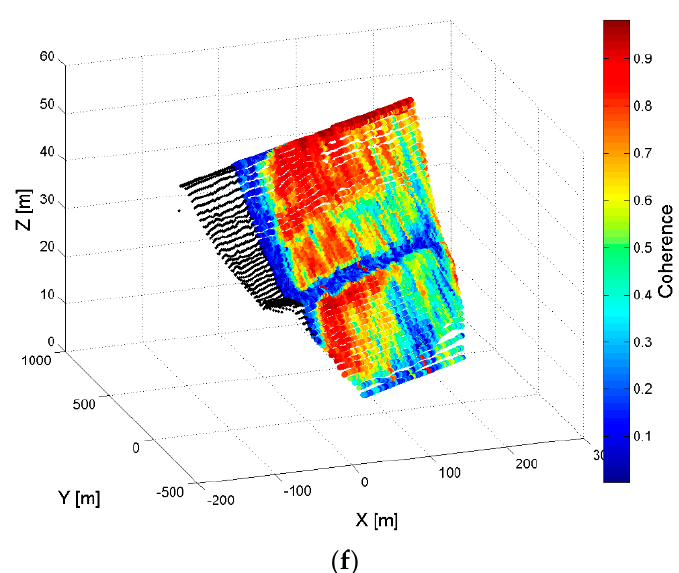
Figure 8. Marana-Capacciotti dam, Cerignola. NRCS and interferometric coherence displayed in radar coordinates ( a , b ), Cartesian coordinates ( c , d ) and rendered on a Digital Elevation Model (DEM) of the dam ( e , f ).